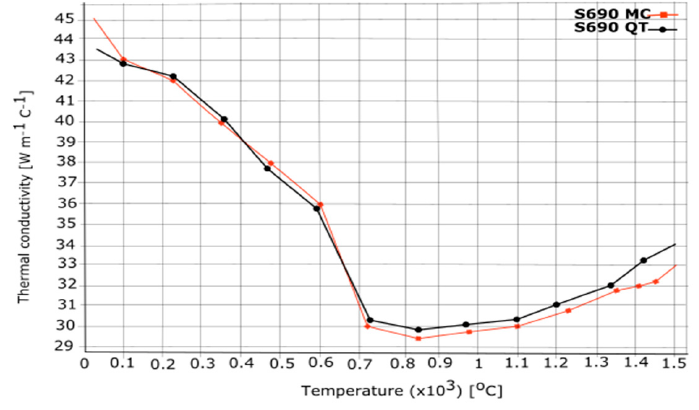
Figure 3. Thermal conductivity.